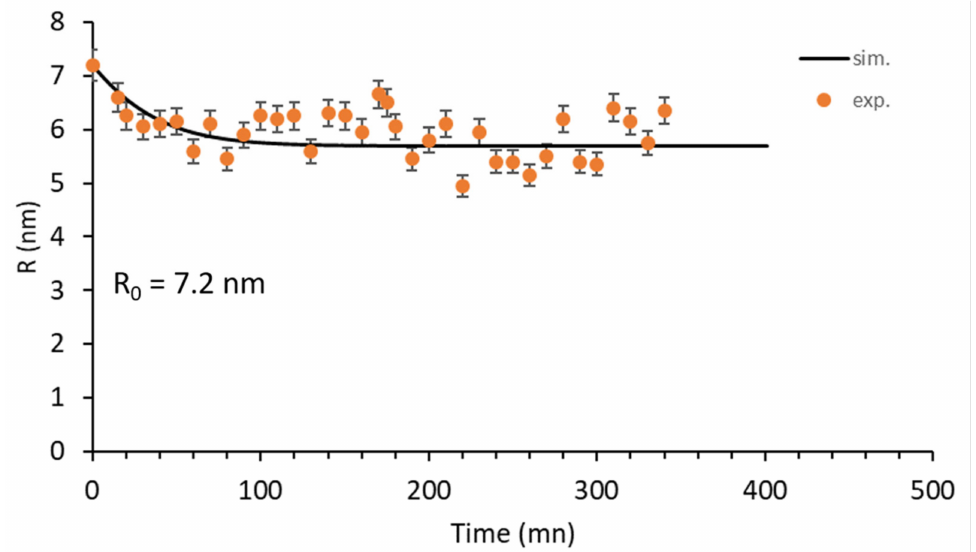
Figure 11. Experimental and theoretical dissolution rate of the nano-oxide presented in Figure 9 during in situ 4 MeV Au 2+ ion irradiation.